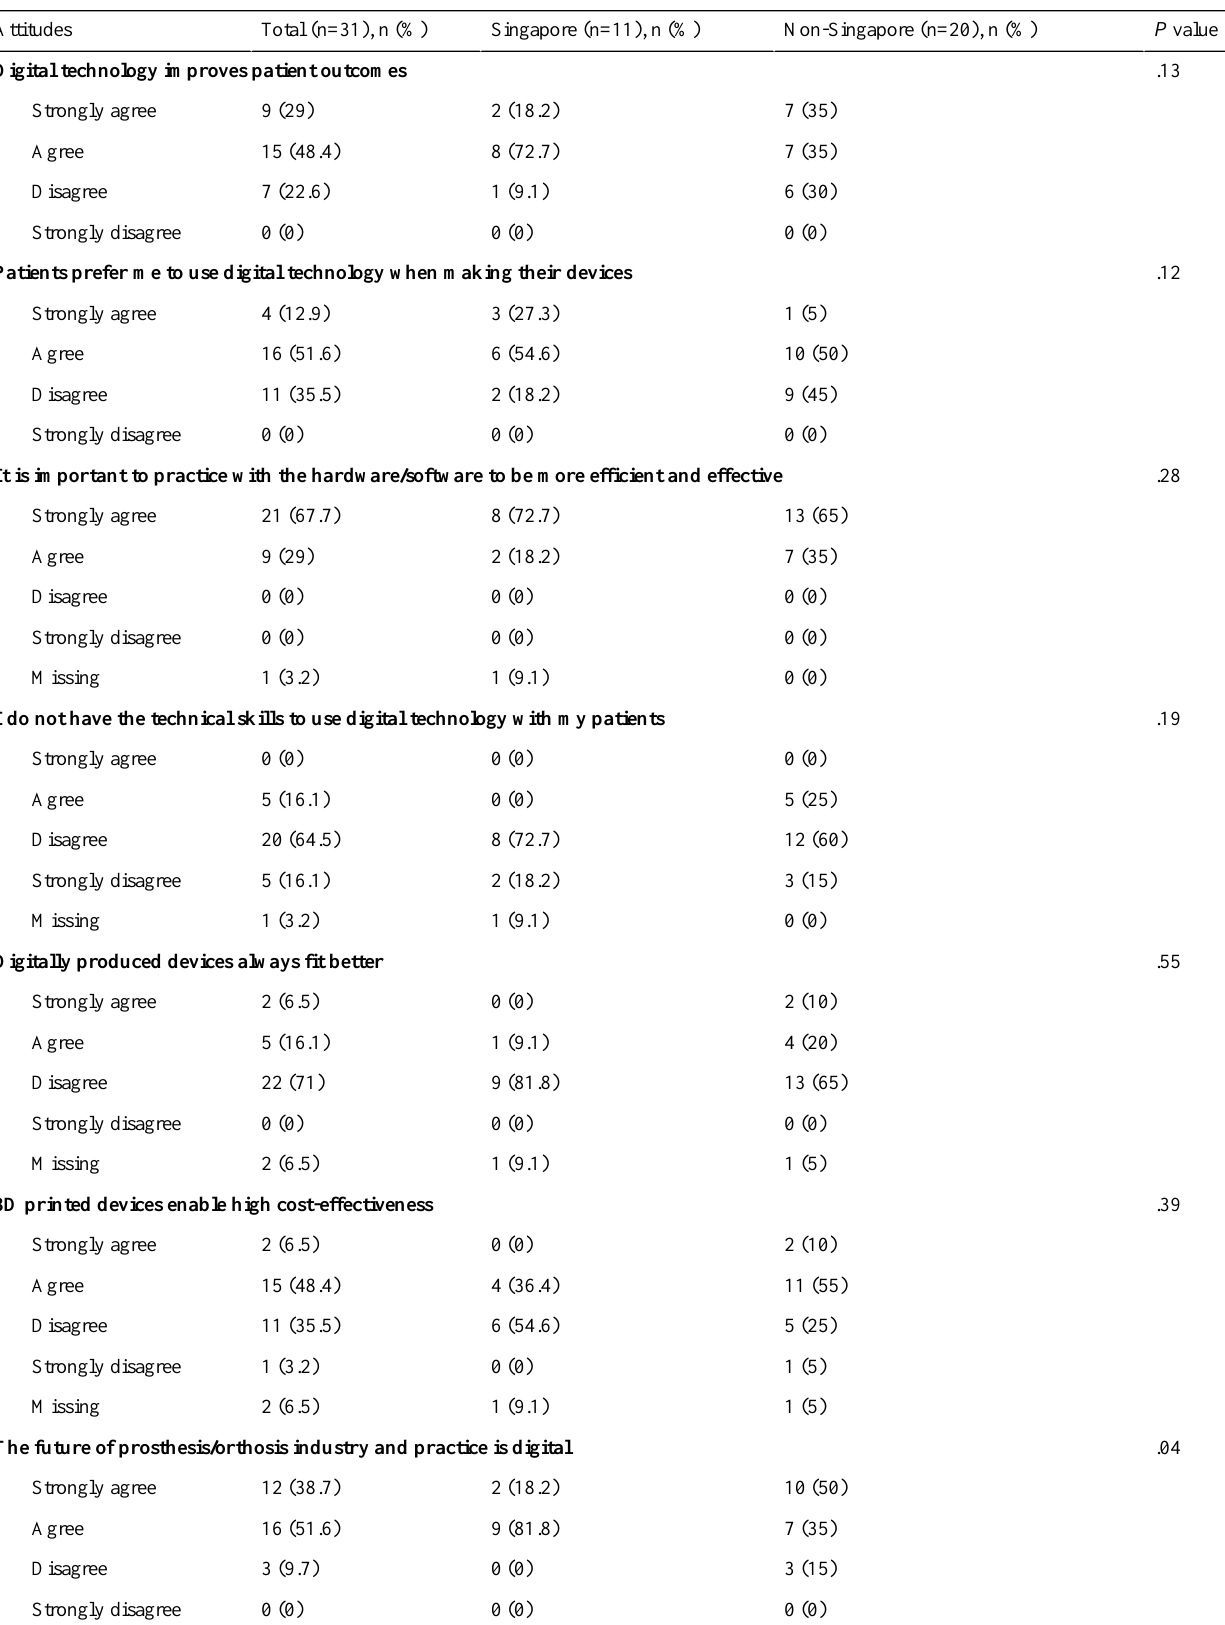
Table 5. Attitudes of prosthetists and orthotists who use digital technologies at